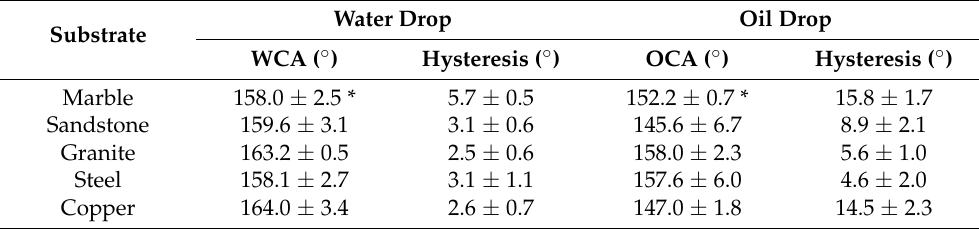
Table 2. Contact angle measurements of water and oil drops on various materials coated with